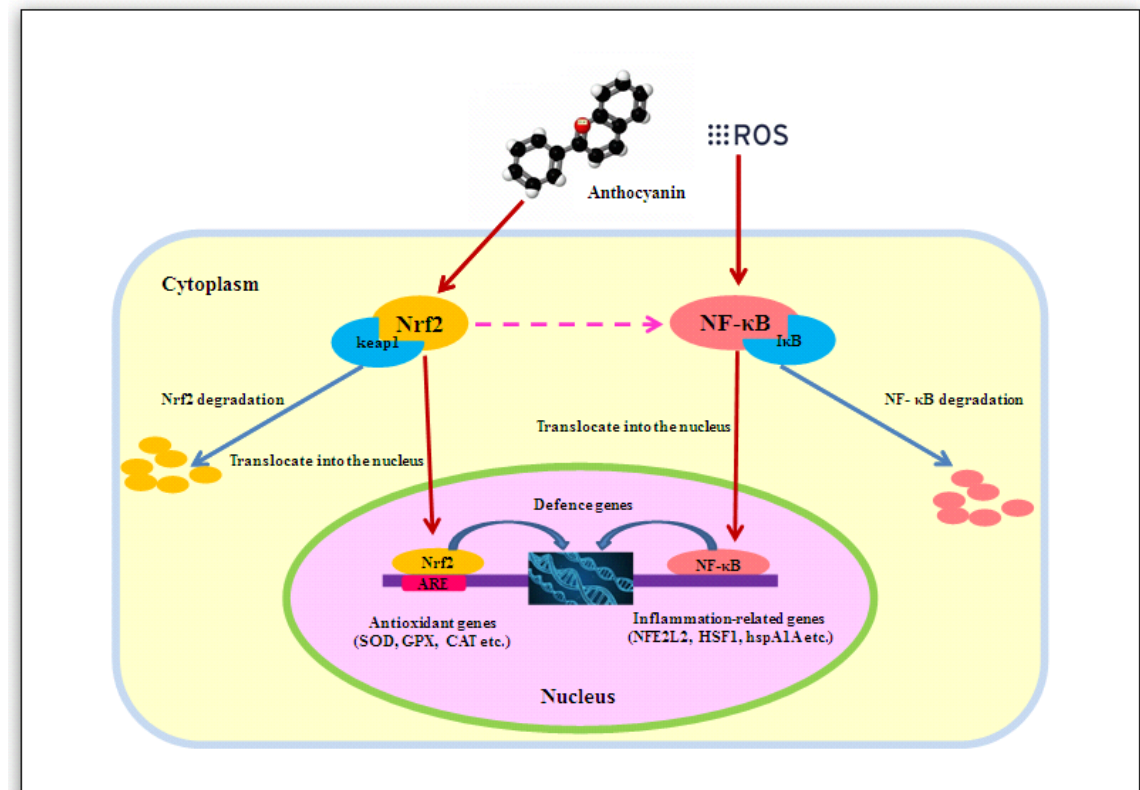
Figure 2. The postulated mechanism by which anthocyanins modulate the Nrf2 and NF- κ B signalling pathways in dairy cows. Nrf2 and Keap1 are bound together in the cytoplasm under normal conditions, whereas anthocyanins may lead to Nrf2 degradation to isolate Keap1. Next, Nrf2 can translocate into the nucleus and then bind to the antioxidant response element and activate expression of related antioxidant genes and detoxifying enzymes. Moreover, anthocyanins can remove FRs and indirectly inhibit the NF- κ B signalling pathway in dairy cows. ROS: reactive oxygen species; Nrf2: nuclear factor erythroid 2-related factor 2; NF- κ B: nuclear factor kappa beta; Keap1: Kelch-like ECH protein; I κ B: I κ B kinase; ARE: antioxidant response element; SOD: superoxide dismutase; GPX: glutathione peroxidase; CAT: catalase; HSF1: heat shock transcription factor 1; hspA1A: heat shock 70 kDa protein